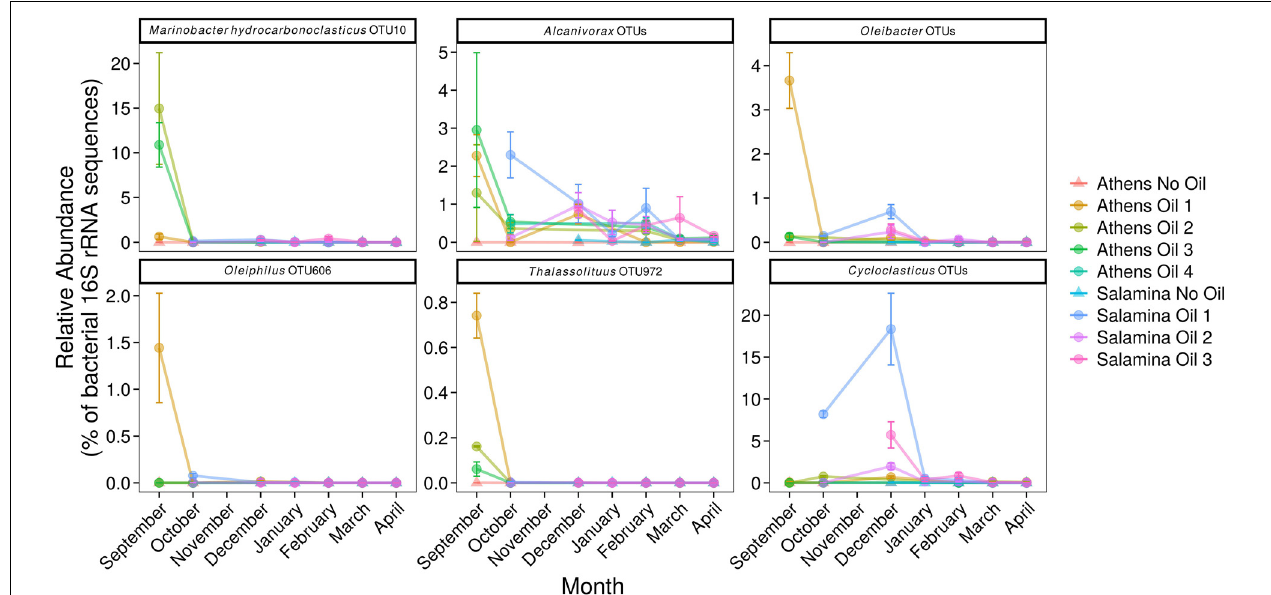
FIGURE 4 | Relative abundance (% of the bacterial community; mean ± SE, n = 3) of 16S rRNA gene OTUs assigned to putative obligate hydrocarbonoclastic bacteria (including OTU-10 which has a 100% identity match to M. hydrocarbonoclasticus ) in sediments from control (Suffix “No Oil”) and contaminated (Suffix “Oil”) sites along the Athens Riviera and Salamina coastline, from September 2017 to April 2018. No samples were collected for all Salamina sites in September 2017, “Salamina No Oil” in October 2017, or all Salamina and Athens sites in November 2017. Bacteria and Archaea OTU tables are available in Supplementary Tables S3 , S4